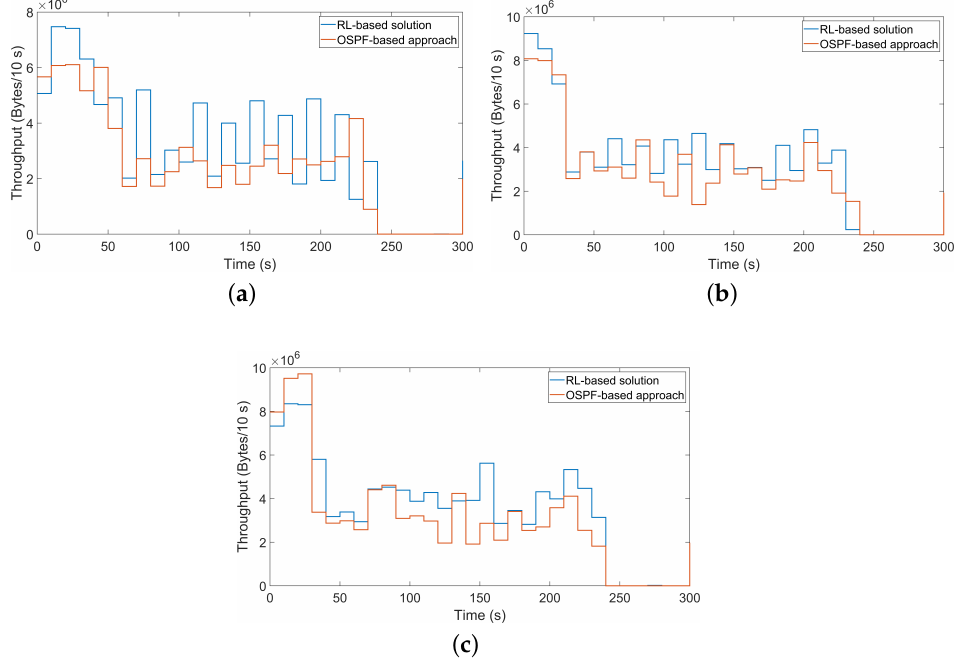
Figure 6. Network throughput during video transmission under low traffic loads in three different topologies. ( a ) Abilene; ( b ) Geant; ( c )